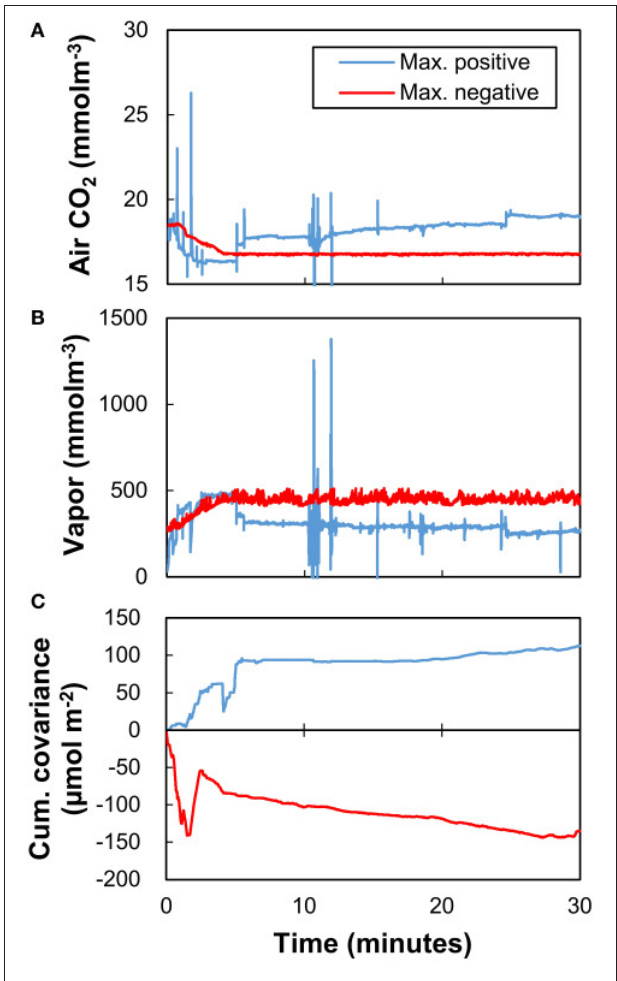
FIGURE 4 | Instantaneous values of (A) atmospheric CO 2 concentration, (B) water vapor (atmospheric H 2 O) concentration, and (C) cumulative covariance of atmospheric CO 2 concentration and vertical wind speed calculated with PP1 when the CO 2 fluxes showed the largest positive value (156.5 µ mol m − 2 s − 1 ; blue) and the largest negative value ( − 217.9 µ